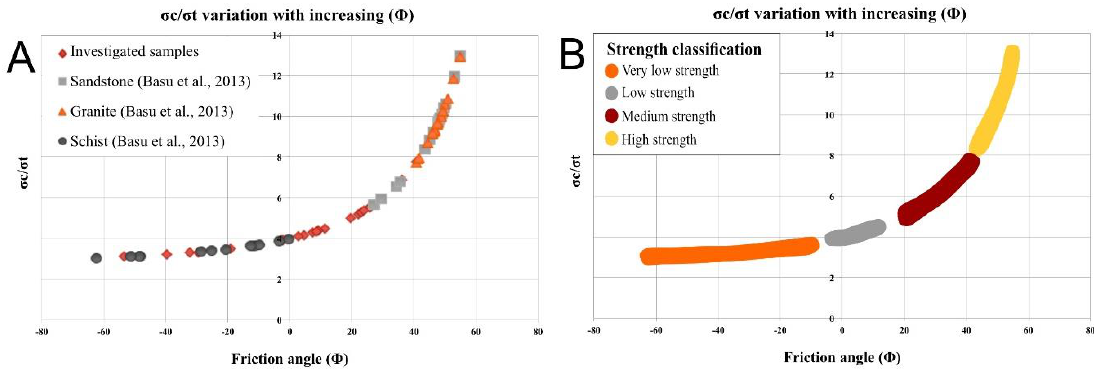
Figure 12. ( A ) Plot showing the relationship between the calculated friction angle and the ( σ c / σ t ) ratio for the investigated samples and data from the literature. ( B ) Classification of rocks based on their strength. The rock strength estimate is based on the field occupied by the same samples in Figure 8A, whereas the fields in ( B ) are derived from the cluster of points in ( A ). Grouping of the ( σ c / σ t ) ratio shows a relationship between the ( σ c / σ t ) and the strength classification; therefore, it appears that the ( σ c / σ t ) can potentially be used to classify rock strength.